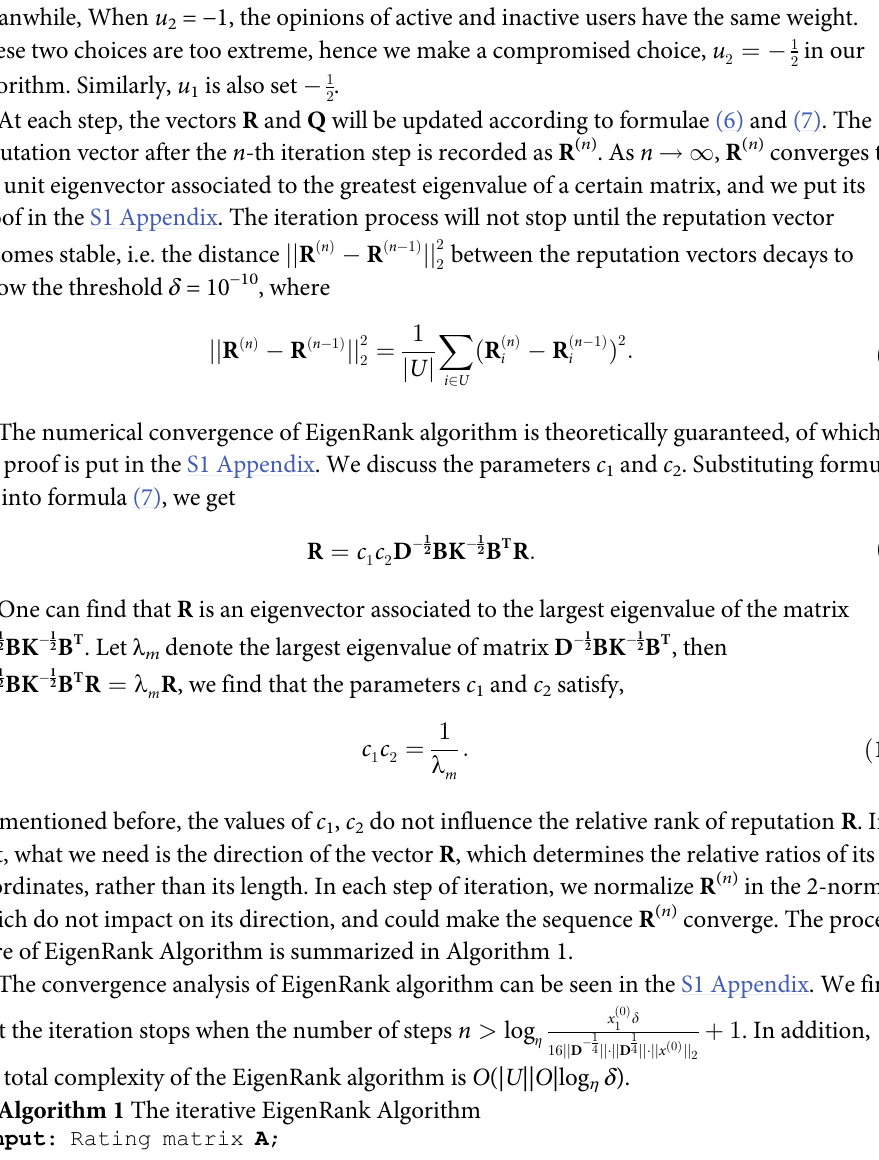
Algorithm 1 The iterative EigenRank